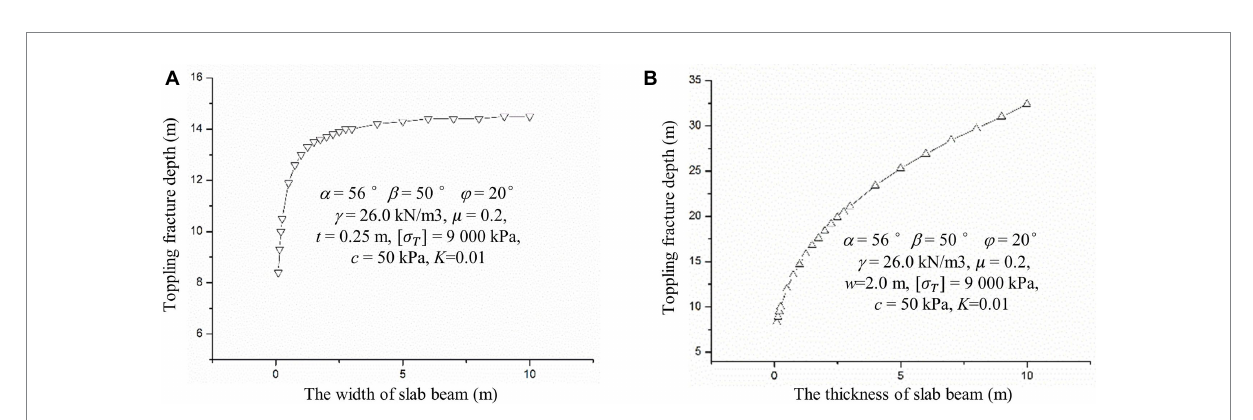
decreased slab beam. The smaller the toppling fracture depth (TFD), the more likely the toppling failure will